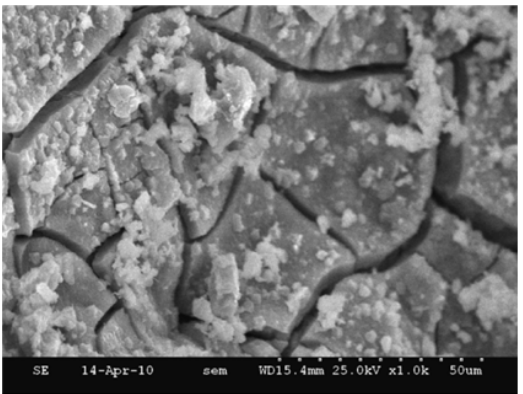
Figure 15. Cracks caused by alkali ‐ silica reaction of paste containing EFS [127].